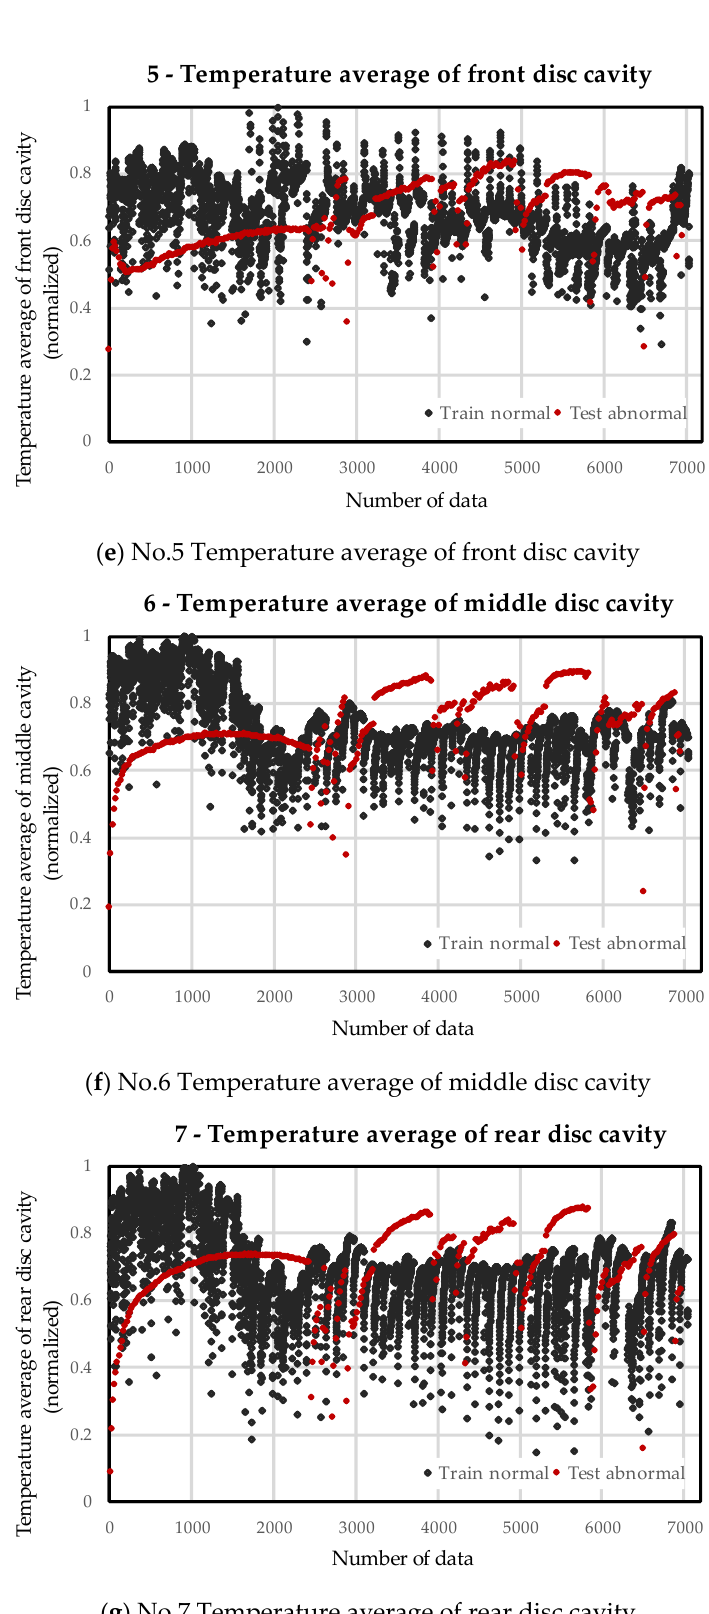
Figure 5. Normal and abnormal datasets.